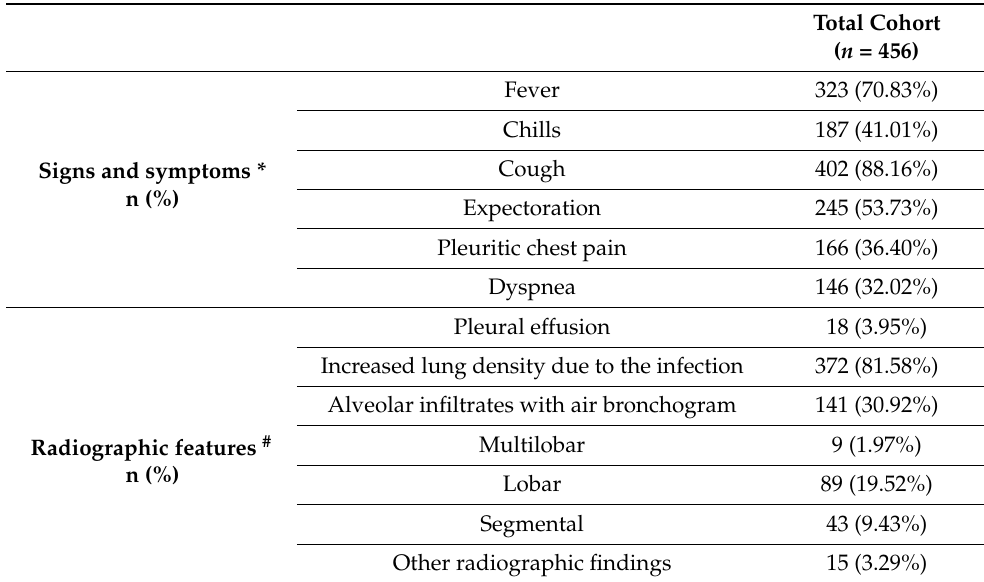
Table 2. Clinical presentation of study population in the whole